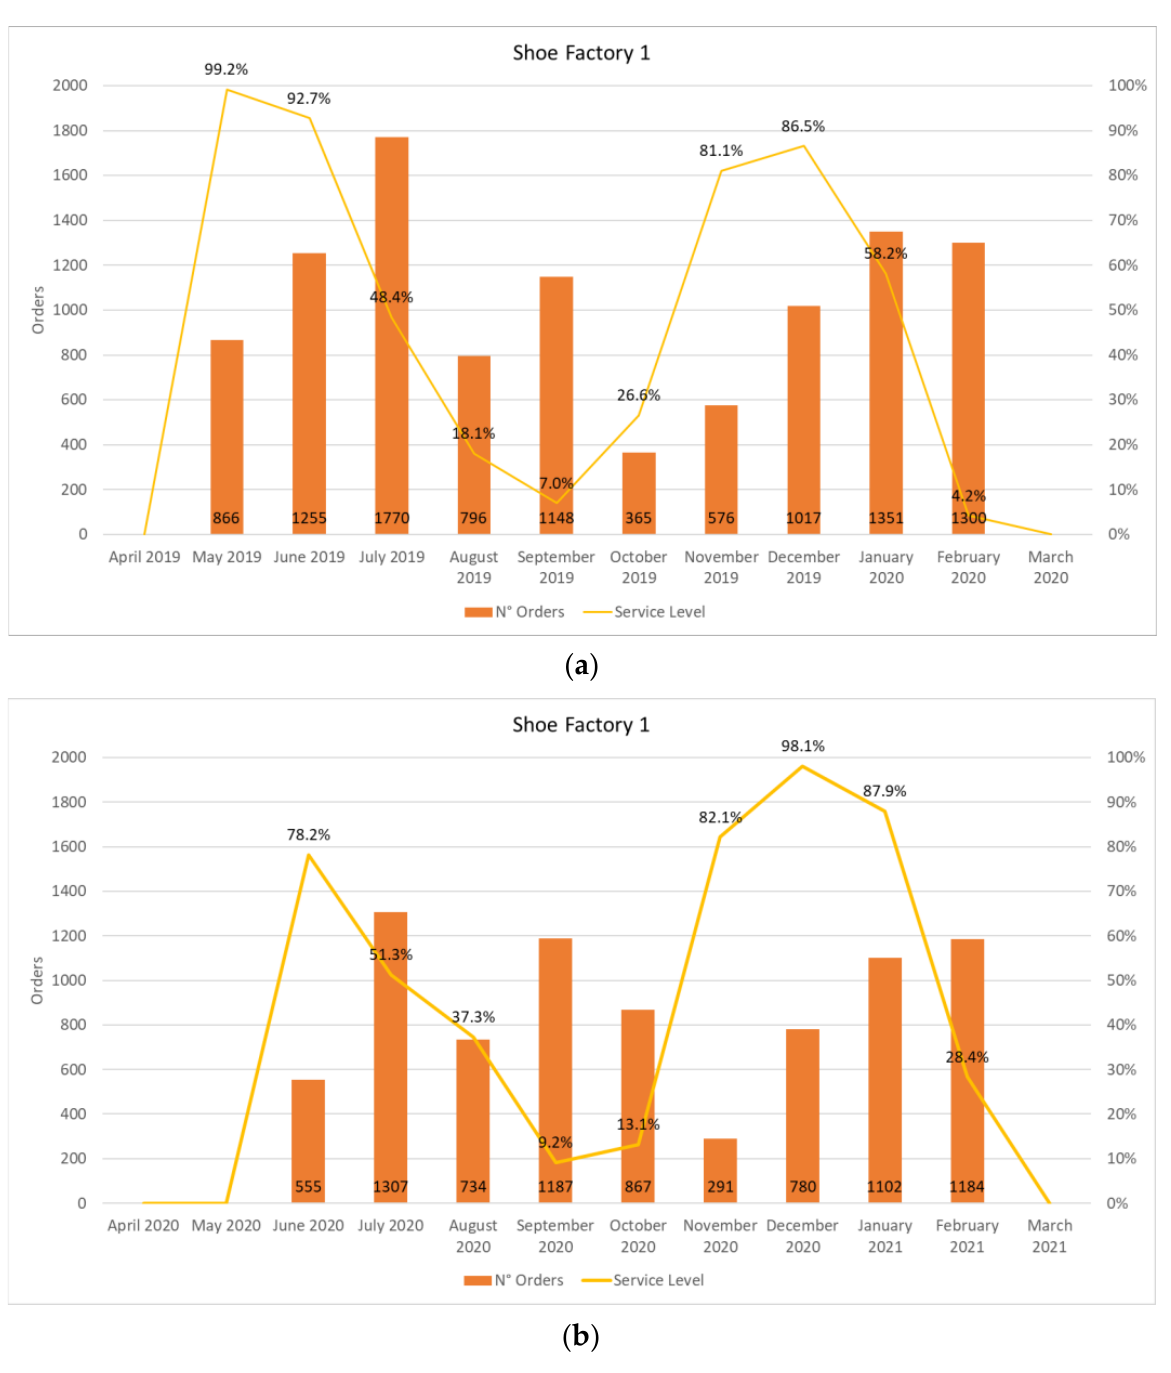
Figure 6. Shoe Factory 1 — monthly service level and N° of orders, considering AW19-SS20 seasons ( a ) and AW20-SS21 seasons ( b ).